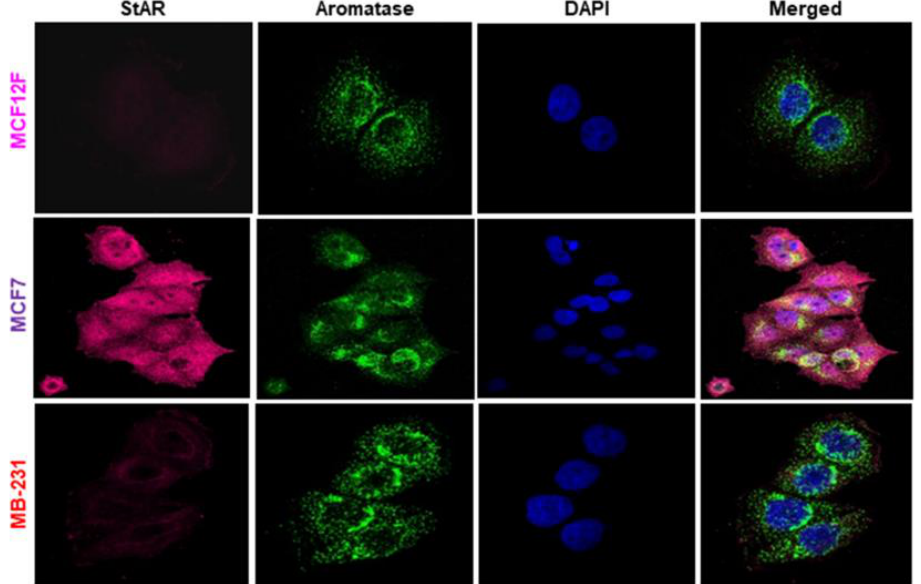
Figure 2. Immunofluorescence analyses of StAR and aromatase in MCF12F, MCF7, and MDA-MB-231 cells, which were grown in 12 mm coverslips placed in 6-well plates to 75–80% confluence. Cells were then processed for immunostaining following procedures described under Materials and methods. Images were taken using a Nikon T1-E confocal microscope with a 60X objective. Representative immunofluorescence images (N = 3) illustrate relative expression of StAR, aromatase, DAPI, and their merged groups. Images were taken with the same laser power and gain and represent a max- imum projection intensity derived from a Z-stack.